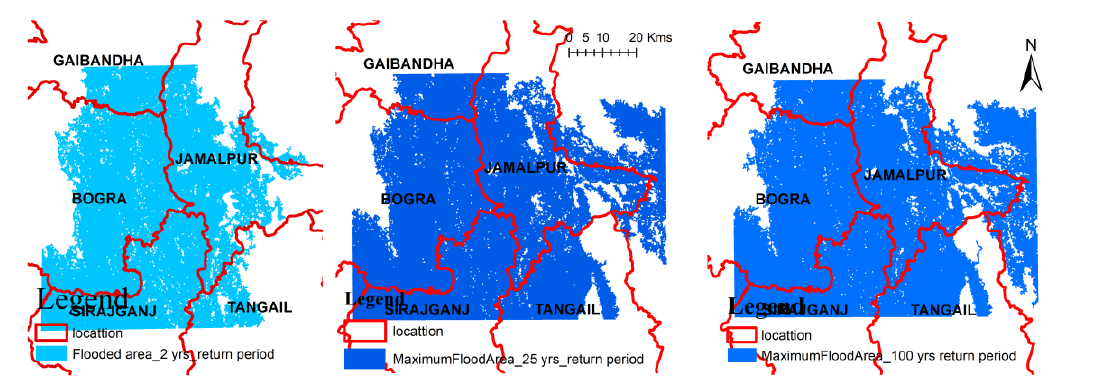
Fig.5. Flood extent